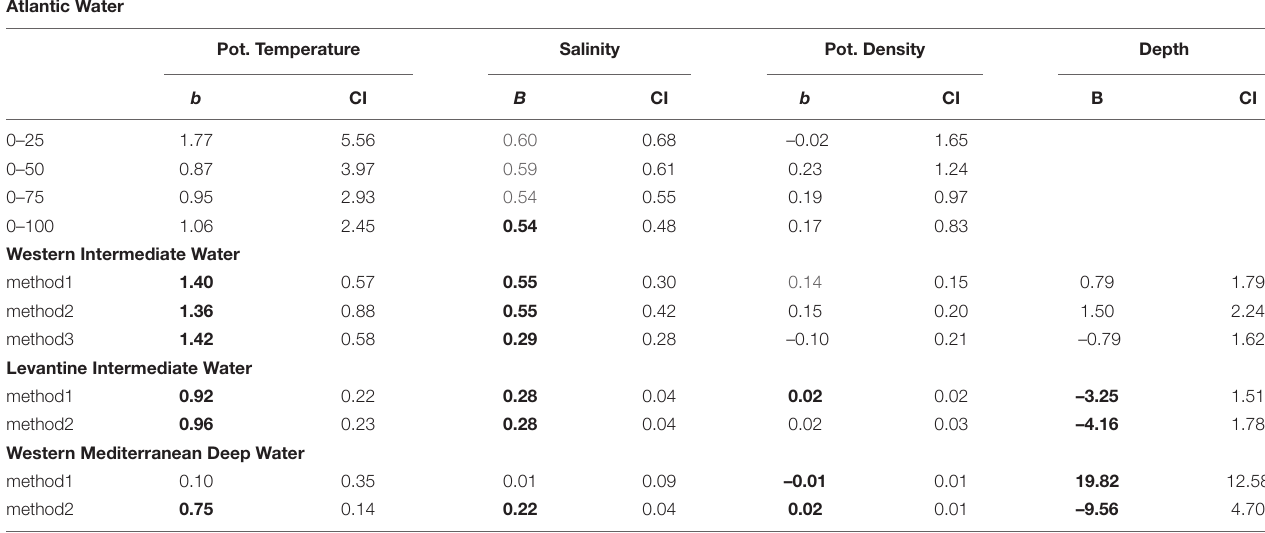
TABLE 1 | Atlantic Water: Linear trends for the AW potential temperature, salinity, and potential density averaged for the upper 25, 50, 75, and 100 m layers. Atlantic Water Pot. Temperature Salinity Pot. Density Depth b CI B CI b CI